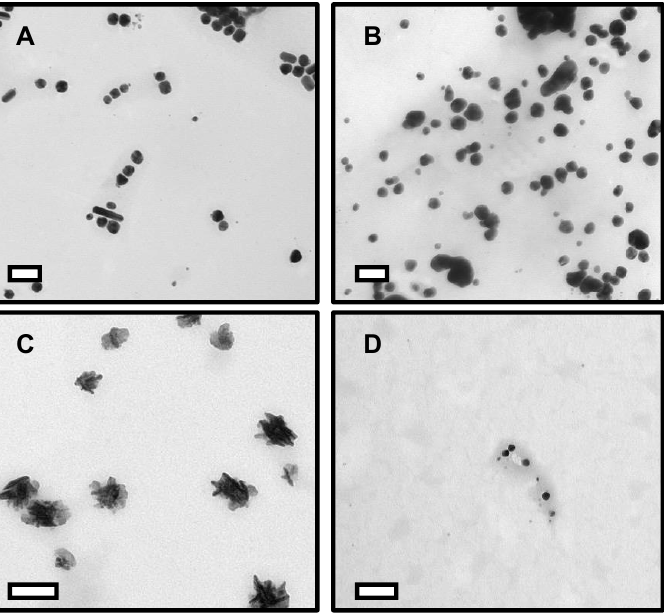
Figure 2. Transmission electron microscopy (TEM) images of surface-stabilized silver and copper nanoparticles. ( A ) CTAB-AgNPs ( B ) PVP-AgNPs ( C ) CTAB-CuNPs ( D ) PVP-CuNPs. Scale bar represents 100 nm.